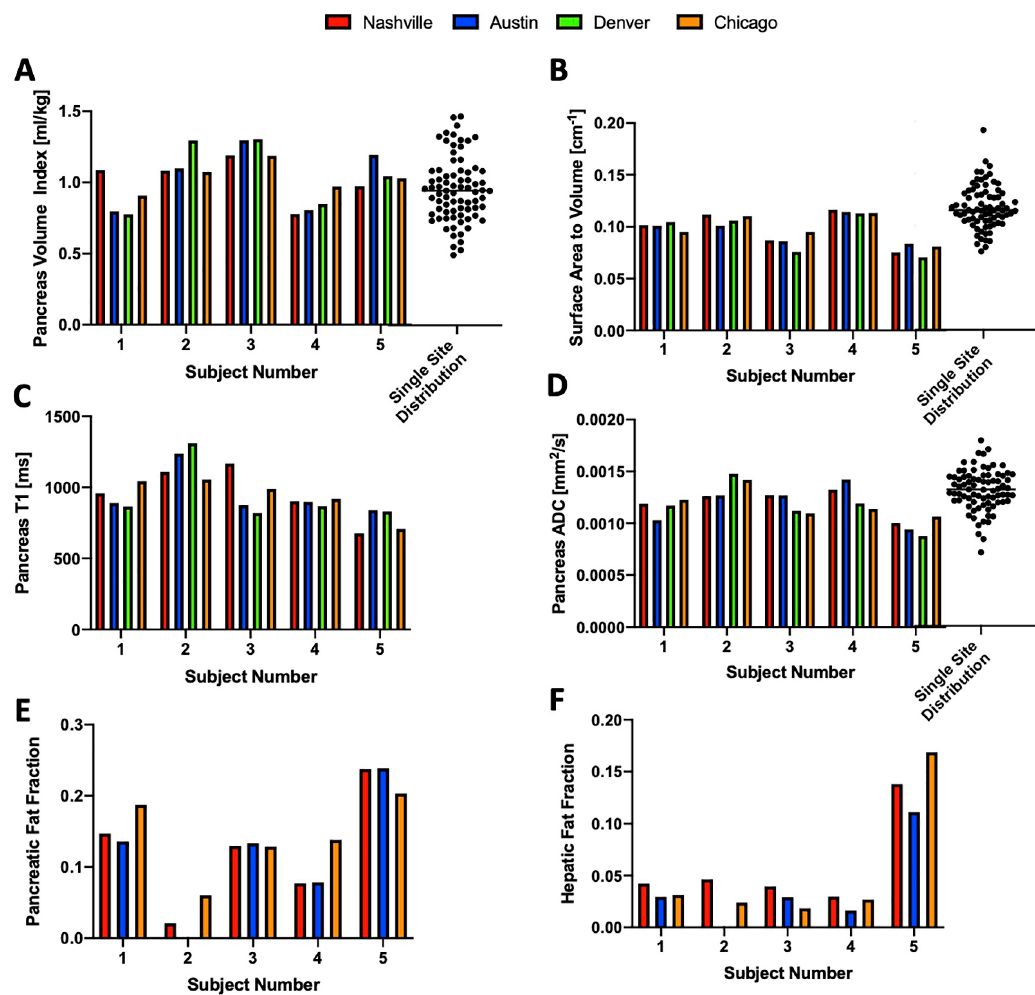
Fig 3. Quantitative MRI measures for 5 individuals scanned on four different MRI centers. Values for each MRI measurement of the pancreas are displayed for: A) pancreas volume index (PVI), B) surface area to volume ratio, C) longitudinal relaxation time (T1), D) apparent diffusion coefficient (ADC), E) pancreatic fat fraction, and F) hepatic fat fraction. Note that fat fraction was not measured in Denver due to a lack of the requisite software. For the graphs of PVI, surface area to volume ratio, and ADC, the distribution of values calculated in healthy volunteers at a single site study (updated from a previously published study [5]) is indicated by dot plot in panels A, B, D.